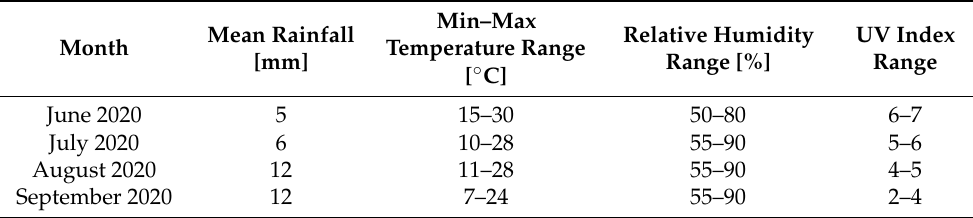
Table 3. Weather data for the outdoor, aboveground weathering test site for the 3-month test period obtained from